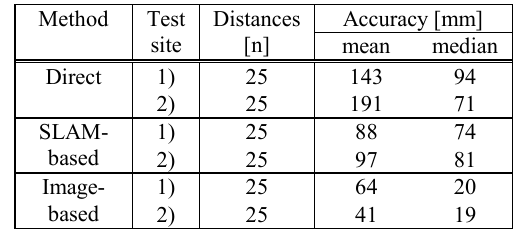
Table 4. Summary of accuracies of 3D distance observations using different georeferencing methods (Direct, SLAM-based and Image-based) for both test sites: 1) “City centre” and 2) “Forest”. The table contains both the mean and median accuracy values. Accuracy represents the length deviation to the ground